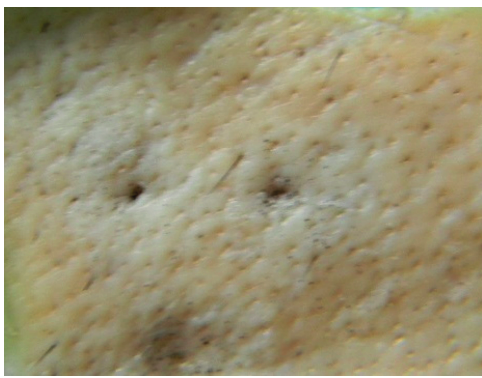
Figure 14. Porcine skin pierced with FSBP (left) and NC (right) single